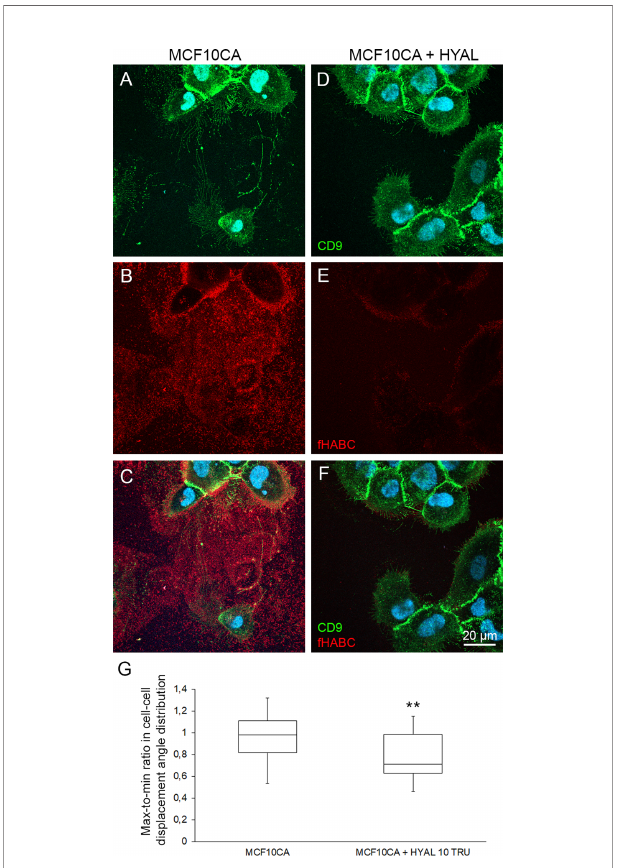
FIGURE 6 | Pericellular hyaluronan promotes the coordination of cell motion in cancer cells. Comparison of live MCF10CA control cells (A – C) and hyaluronidase-digested cells (D – F) stained with FITC-labeled CD9 and fHABC. Blue = nuclei. Whisker and box plot showing the distribution of correlation index (CI) for untreated (left) and hyaluronan-degrading enzyme- treated (right) cancer cells (G) . Plots were constructed using data from 25 and 20 FOVs from 4 experiments for each condition respectively, totalizing several hundreds of cells. The CI for each FOV was normalized to the median CI of untreated cells for the same experiment. **: Wilcoxon rank-text p-value